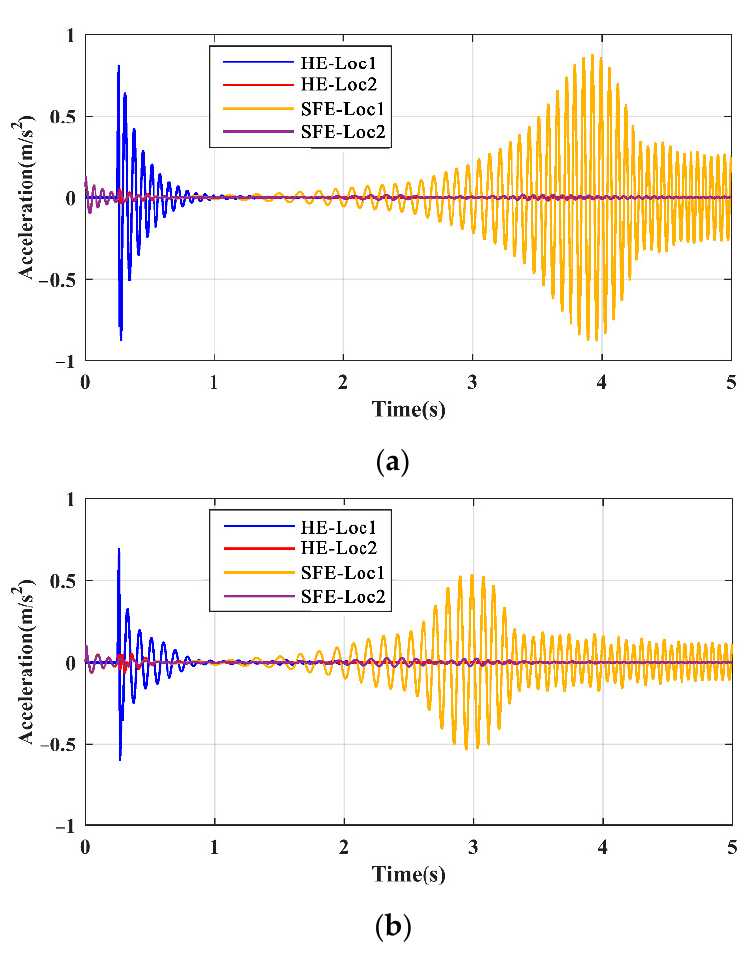
under different damage situations. sors